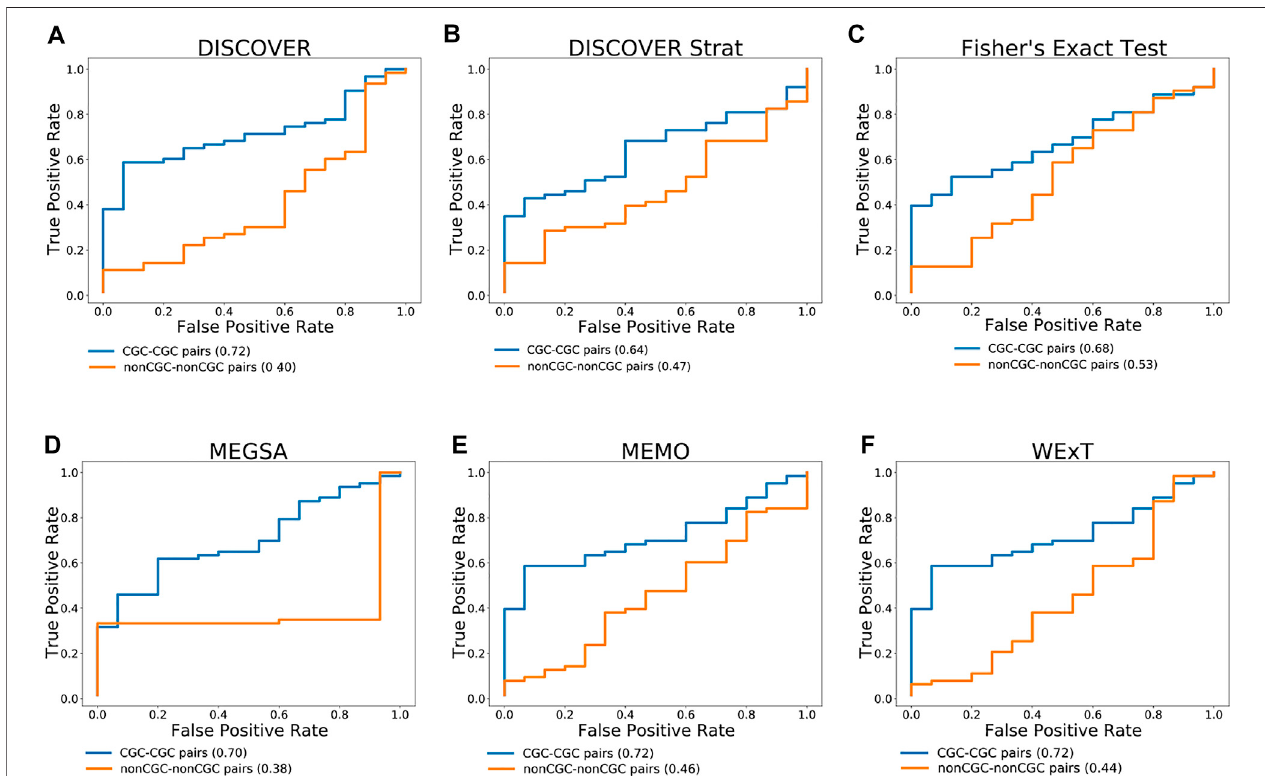
FIGURE3| PerformanceofselectedMEtestsintermsofdiscriminatingTSNandnon-TSNgenepairsbasedonestimatedME p -valuesonCOADREADdata.Blue curveisplottedwithCGC genepairsandred curveisplottedwithnon-CGCgenepairs.Mutual exclusivitiesareestimatedwith (A) DISCOVER, (B) DISCOVERStrat, (C) Fisher ’ s Exact Test, (D) MEGSA, (E) MEMo and (G) WeXT respectively.